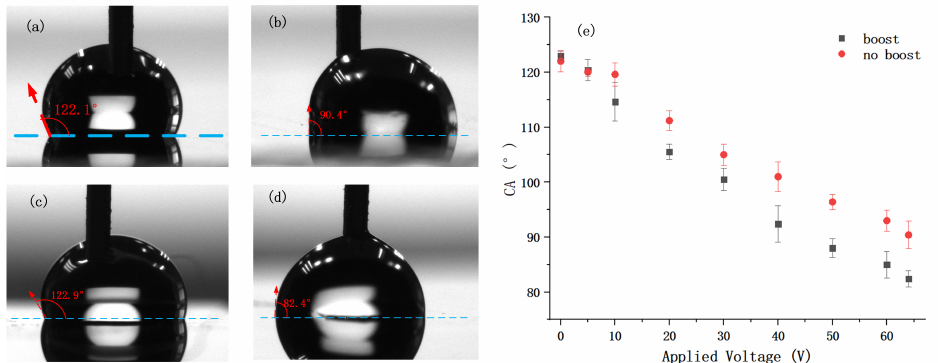
Figure 9. Experiments results and photos of CA test: ( a ) 122.1 ◦ at 0 V of 1T1C pixel; ( b ) 90.4 ◦ at 65 V of 1T1C pixel; ( c ) 122.9 ◦ at 0 V of 3T4C pixel; ( d ) 82.4 ◦ at 65 V of 3T4C pixel; ( e ) relationship of CA and applied voltage of the pixel with (black) and without (red) boost circuit.